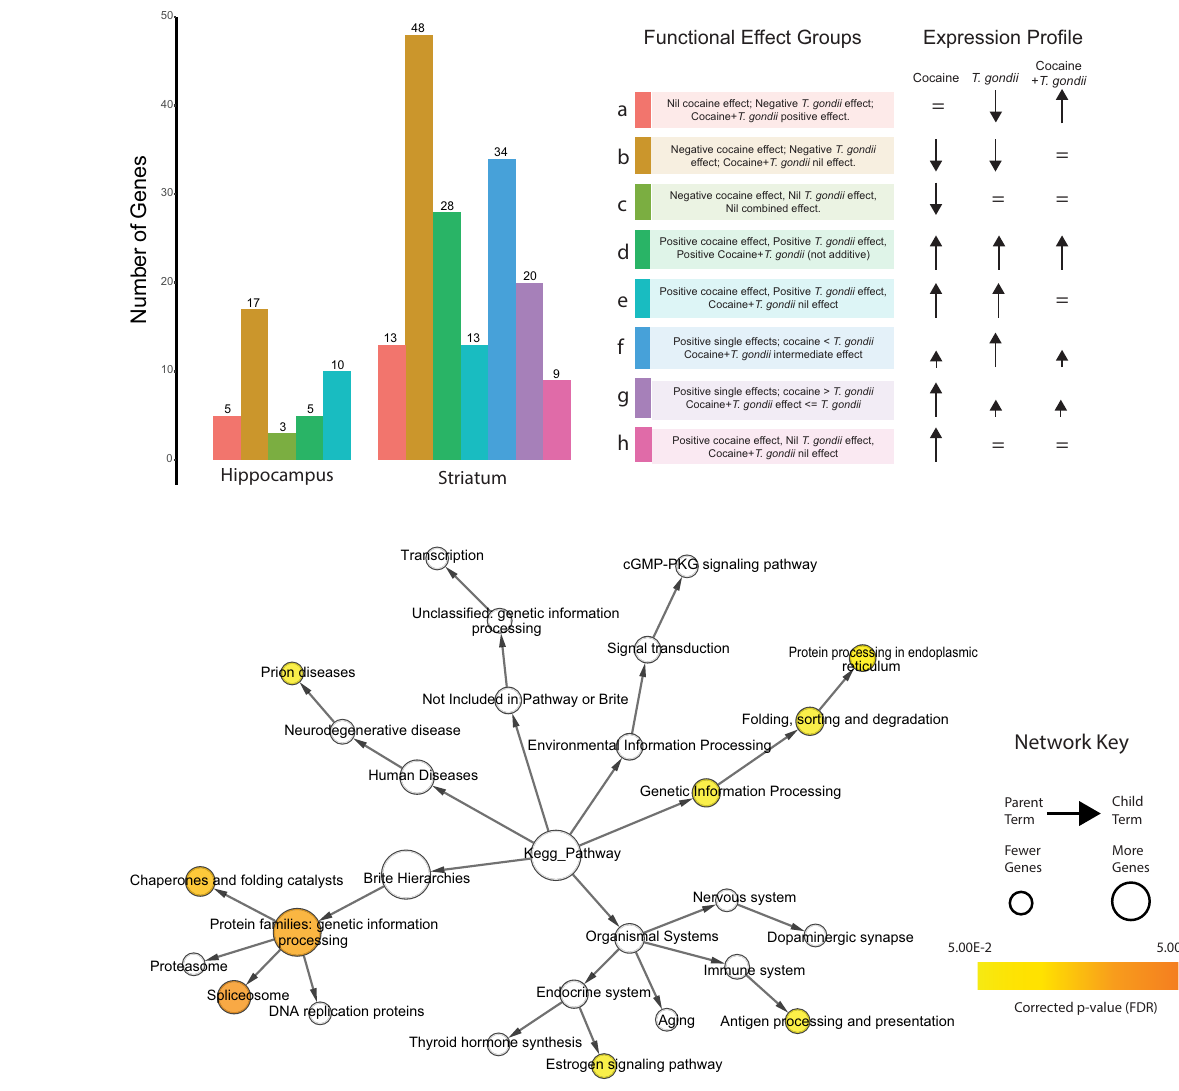
Fig 6. Functional characterization of mouse genes with interacting effects. A. Frequency of mouse genes with statistically significant interactions by functional effect category (hippocampus and striatum). B. Network visualization of KEGG pathway enrichments for functional effect group b in striatum (largest category) providing insight into parent-child relationships of significantly enriched terms. For example, “spliceosome” and “chaperones and folding catalysts” can be seen to be most specifically as well as most significantly enriched. For context, all significantly enriched terms before correction for multiple testing are shown. Colors represent significant terms after multiple testing correction (hypergeometric test, FDR < 0.05).